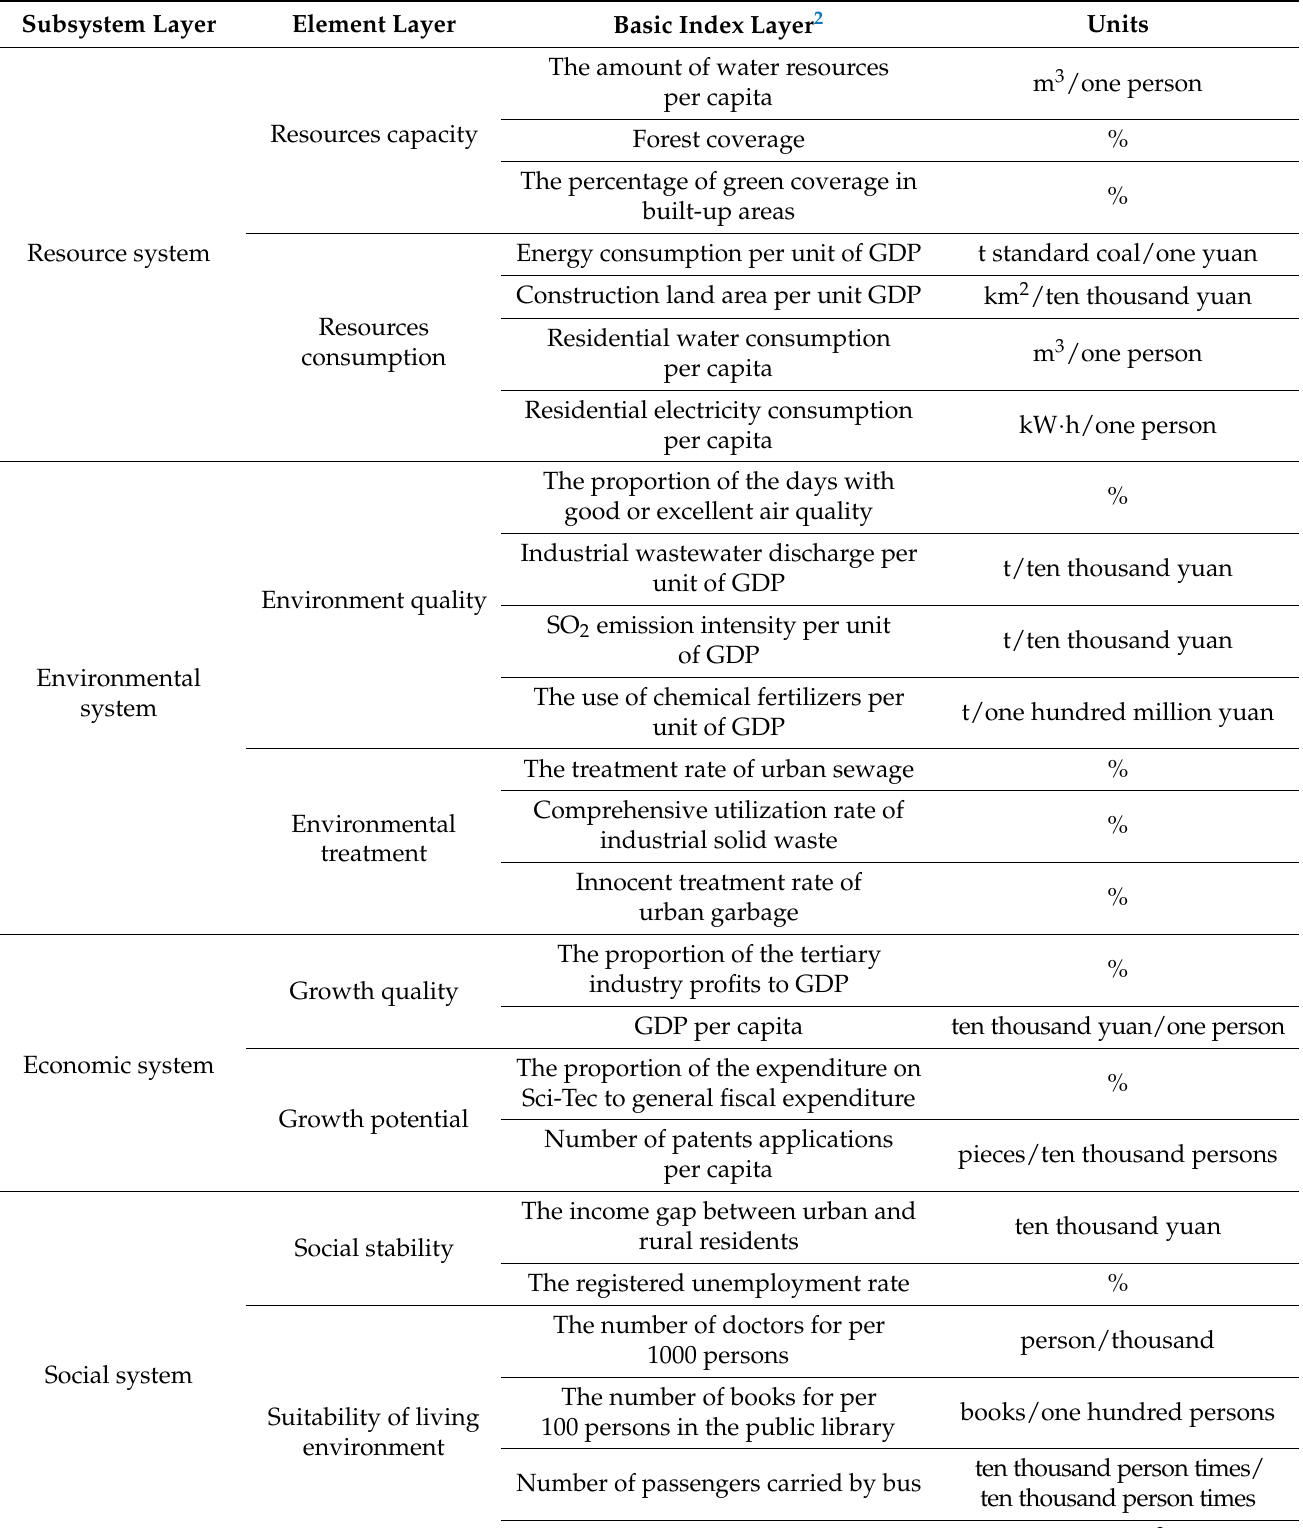
Table 1. Evaluation index system of green development of